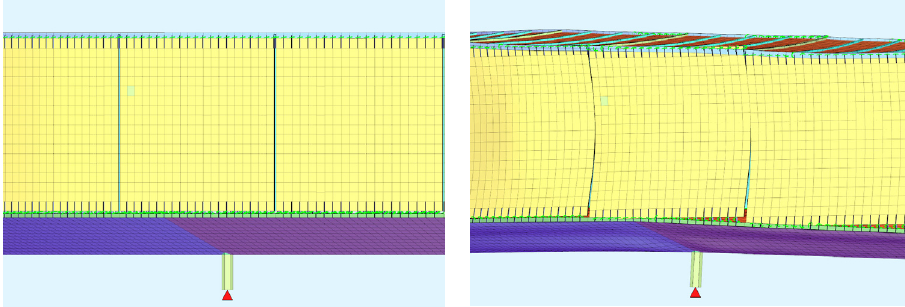
Figure 14: The soft connection between steel and glass under action, displacements are scaled up.